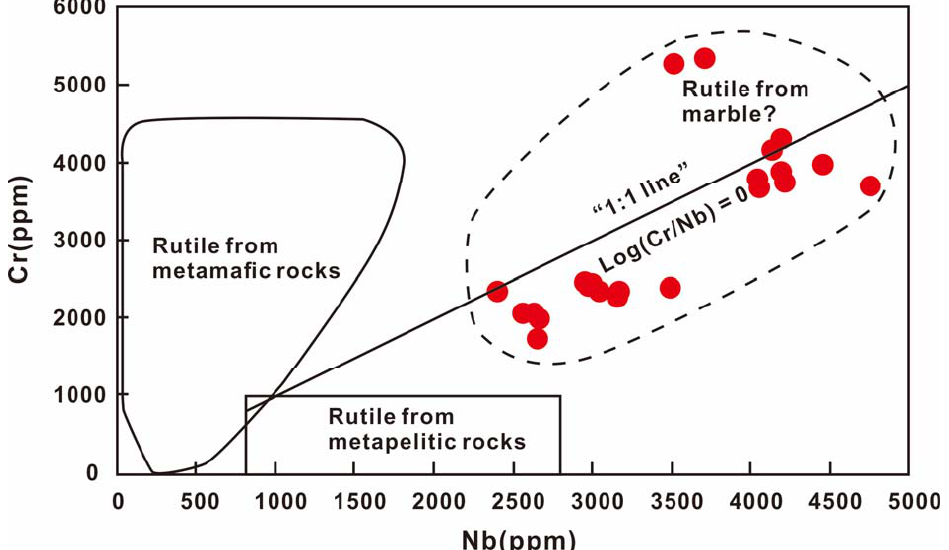
Figure 6. Cr-Nb discrimination diagrams of rutile inclusions. Fields of metamafic and metapelitic rutile are from [25,26]. Log (Cr/Nb) = 0 according to [27].